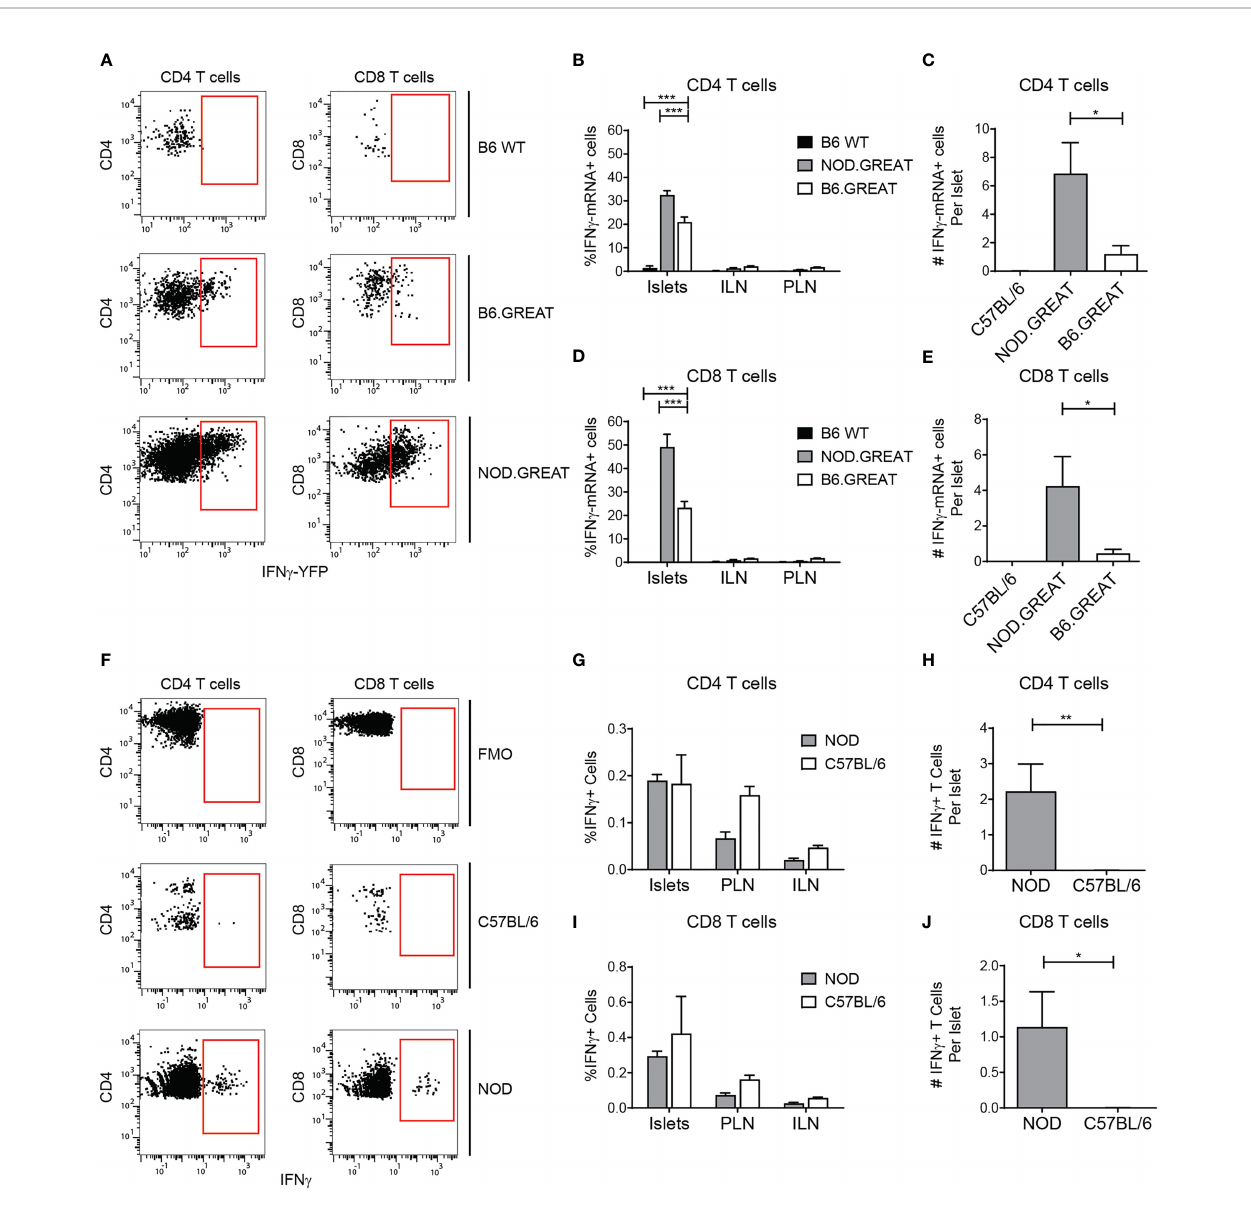
FIGURE 7 | Islet T cells do not express IFN- g in the steady state. Flow cytometry analysis of IFN- g transcript in the GREAT IFN- g transcript reporter (A – E) and IFN- g protein expression by intra-cellular cytokine staining (F – J) . (A) Representative YFP expression in the GREAT IFN- g transcript reporter in islets. (B, D) Percent IFN- g − YFP positive T cells. (C, E) Number of IFN- g − YFP positive T cells per islet. (F) Representative IFN- g protein staining in islets. (G, I) Percent IFN- g protein positive T cells. (H, J) Number of IFN- g protein positive T cells per islet. (B – D) n=3 B6 WT, 7 B6.GREAT, 4 NOD.GREAT from 3 independent experiments. (G – I) n=8 B6 WT, 5 NOD from 3 independent experiments. (A – J) Statistics: *p < 0.05, **p < 0.01, ***p < 0.001. Error bars: SEM. (B, D, G, J) Two-way ANOVA with Bonferroni post- test. (C, E, H, I) One-way ANOVA with Tukey ’ s multiple